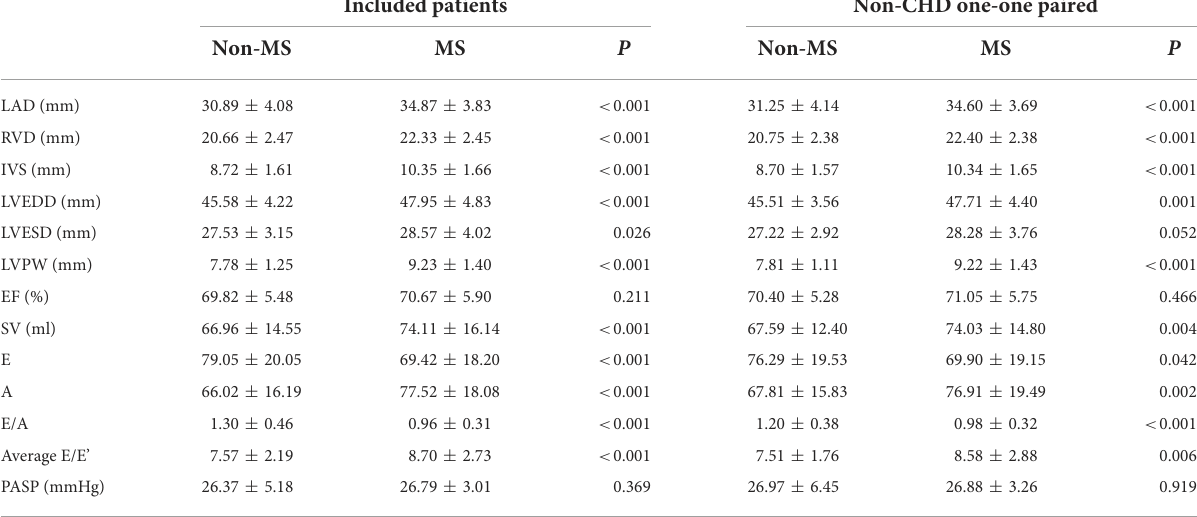
TABLE 2 The figures of ultrasound of included patients and non-CHD one-one paired. Included patients Non-CHD one-one